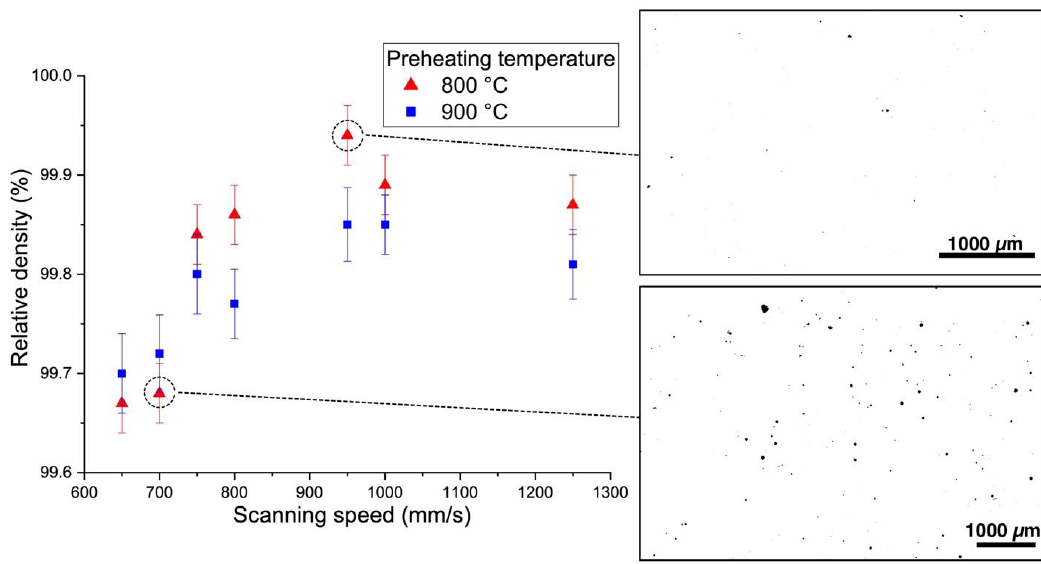
Figure 6. Effect of scanning speed and platform preheating temperature on the relative density of the samples fabricated from GA powder with cross-section images showing typical pore distribution.